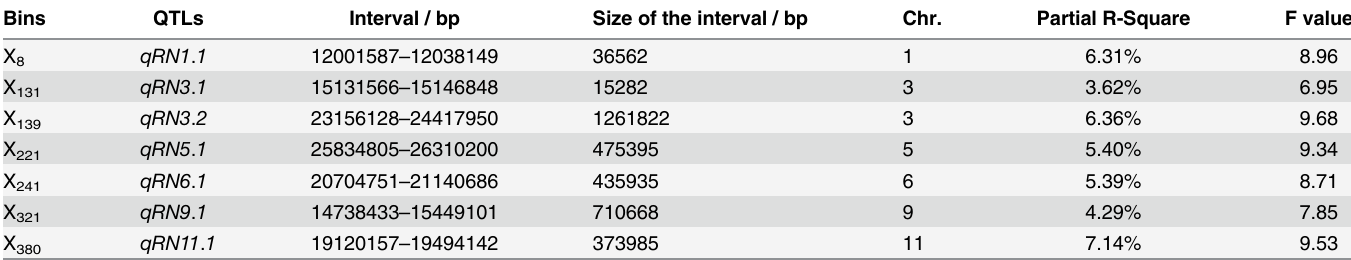
Table 7. QTLs mapping of